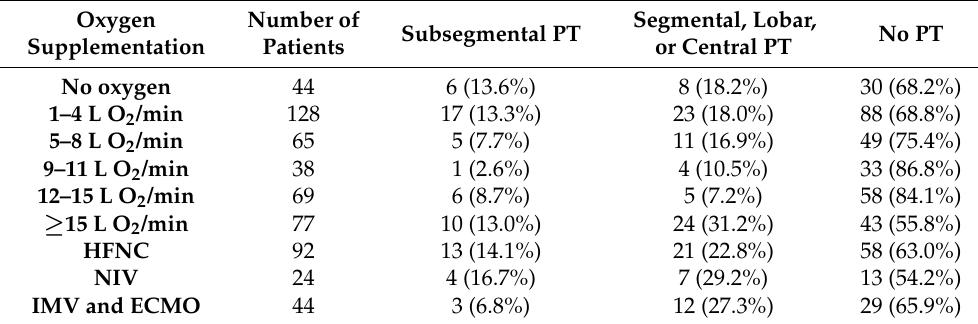
Table 2. Frequency of subsegmental and combined segmental, lobar, or central PT stratified by oxygen supplementation requirement in hospitalized patients with COVID-19.